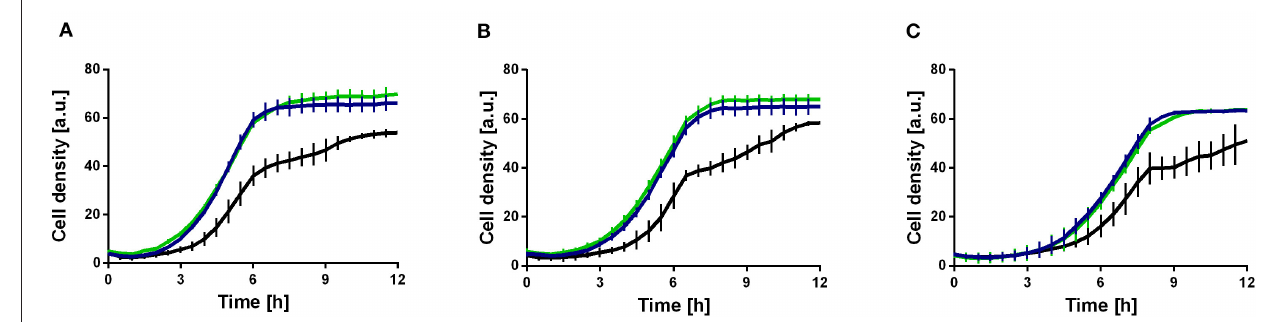
FIGURE 5 | Ethanol tolerance of P. putida KT2440 and derivatives in M9 minimal medium containing different ethanol concentrations. P. putida KT2440 (black), P. putida KT2440 E1.1 (blue), and P. putida KT2440 1 fleQ (green). (A) Minimal medium containing 10g L − 1 glucose and 1% (v/v) ethanol. (B) Minimal medium containing 10g L − 1 glucose and 2% (v/v) ethanol. (C) Minimal medium containing 10g L − 1 glucose and 3% (v/v) ethanol. Growth was detected using a Growth Profiler 960 in 96-well plates. Error bars indicate the standard deviation from the mean ( n =